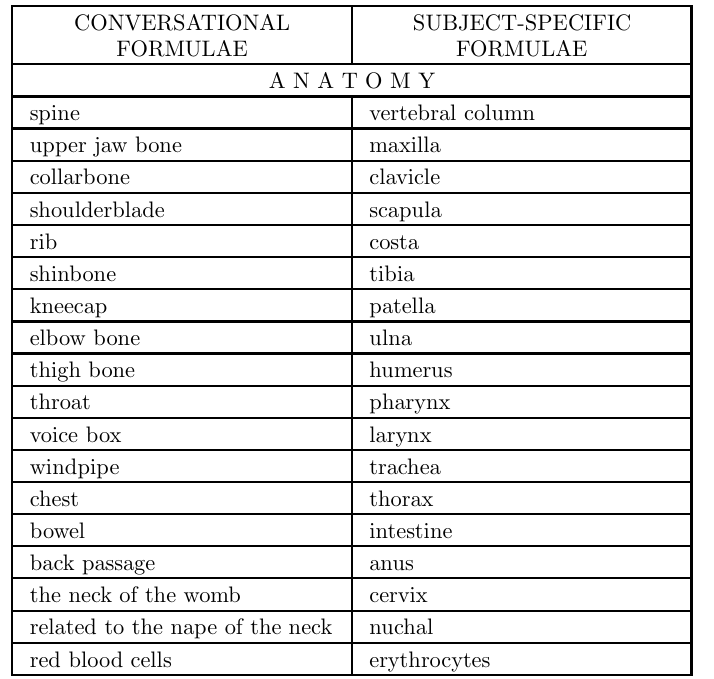
A sample of medical conversational formulae (the right side) and subject- specific formulae (the left side): author’s own